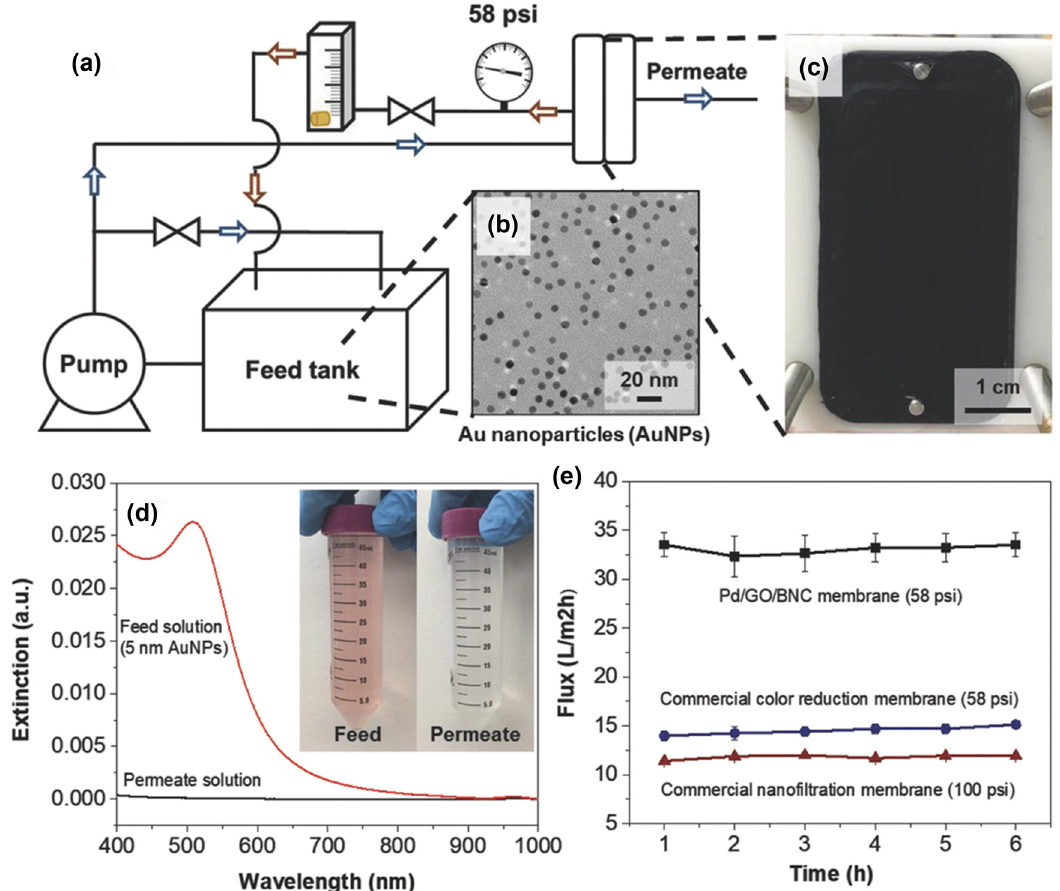
Figure 6: Schematic of the particle rejection and fl ux tests performed for the Pd/GO/BNC nanocomposite membrane: ( a ) layout of the cross fl ow test setup; ( b ) transmission electron microscopy images of the AuNPs with diameters of 5 nm; ( c ) cross - sectional photograph of the membrane in a fl ow cell; ( d ) UV transmittance spectra showing the rejection of AuNPs fi ltered through the nanocomposite material. The inset depicts the feed and permeate solutions. ( e ) Graphical representation of the water fl ux characteristics of nanocomposite membranes, including those of the commercial color reduction and nano fi ltration membranes obtained at applied pressures of 58 and 100 psi, respectively [ 116 ] , Copyright 2018, John Wiley &